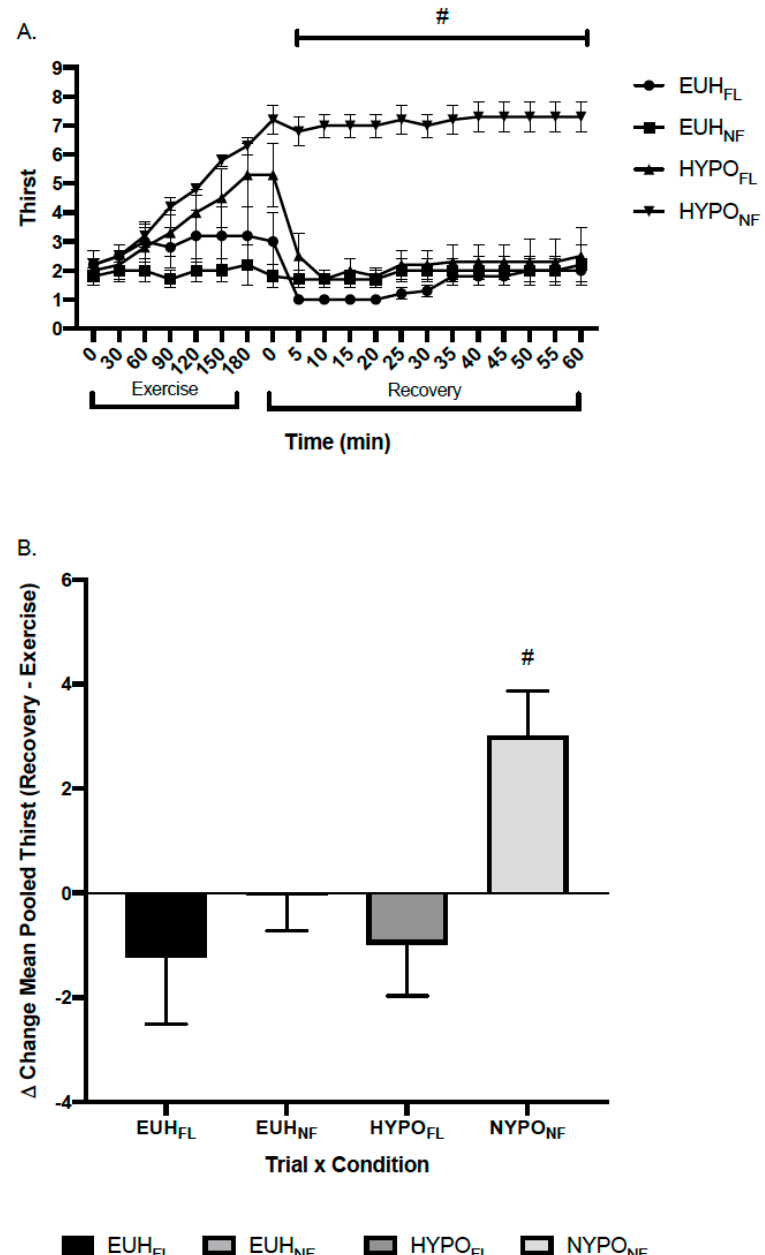
Figure 1. ( A ) Thirst perception throughout exercise and post-exercise recovery and ( B ) delta change (recovery–exercise) of pooled means in thirst perception (TH) by trial × condition. # indicates a significant difference between HYPO FL and HYPO NF , EUH FL , and EUH NF , p < 0.05. EUH FL = minimized fluid losses during exercise and remaining losses replaced during recovery; EUH NF = minimized fluid losses during exercise and did not replace losses during recovery; HYPO FL = fluid restricted during exercise and losses replaced during recovery; HYPO NF = fluid restricted during exercise and losses not replaced during recovery.